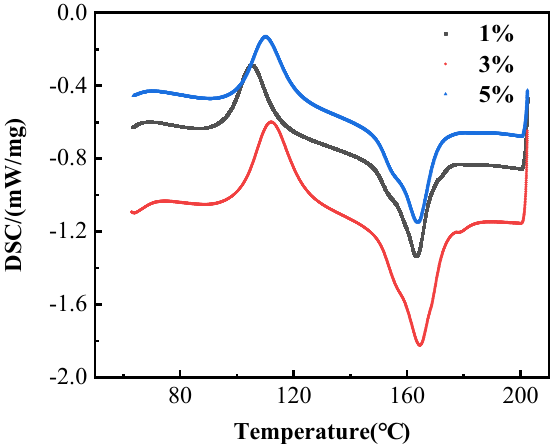
Figure 6. DSC curves of TPU/PLA composites with different compatibilizer contents.